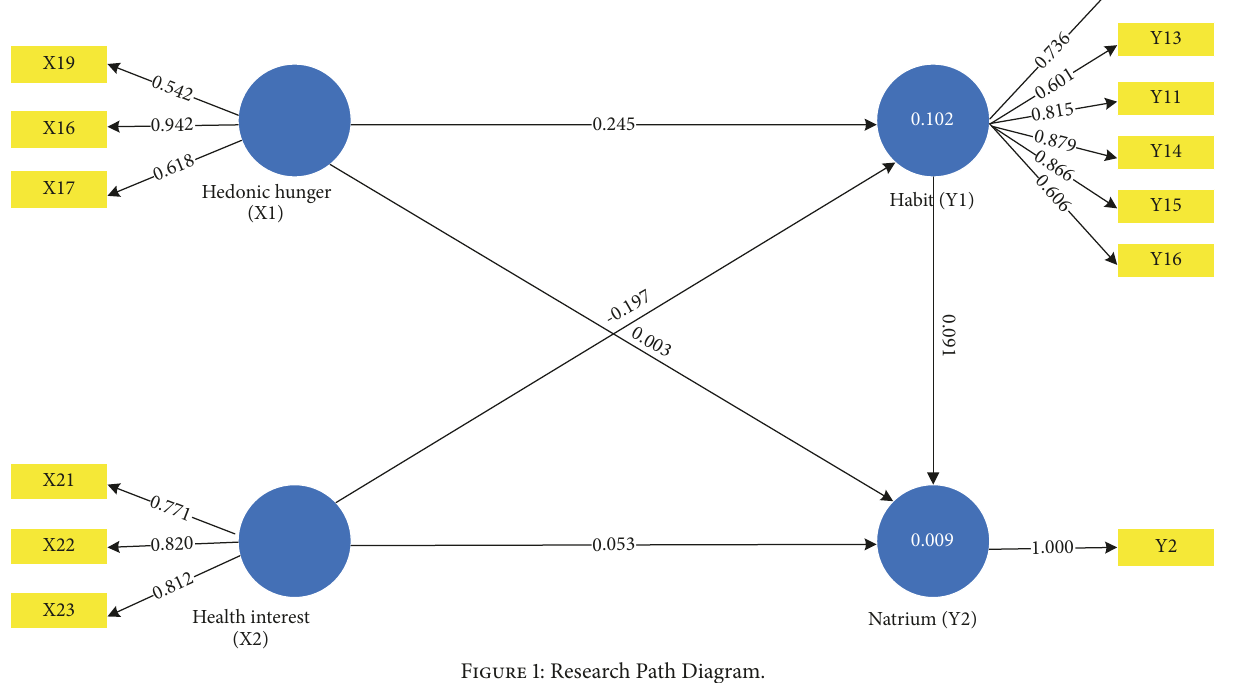
Figure 1: Research Path